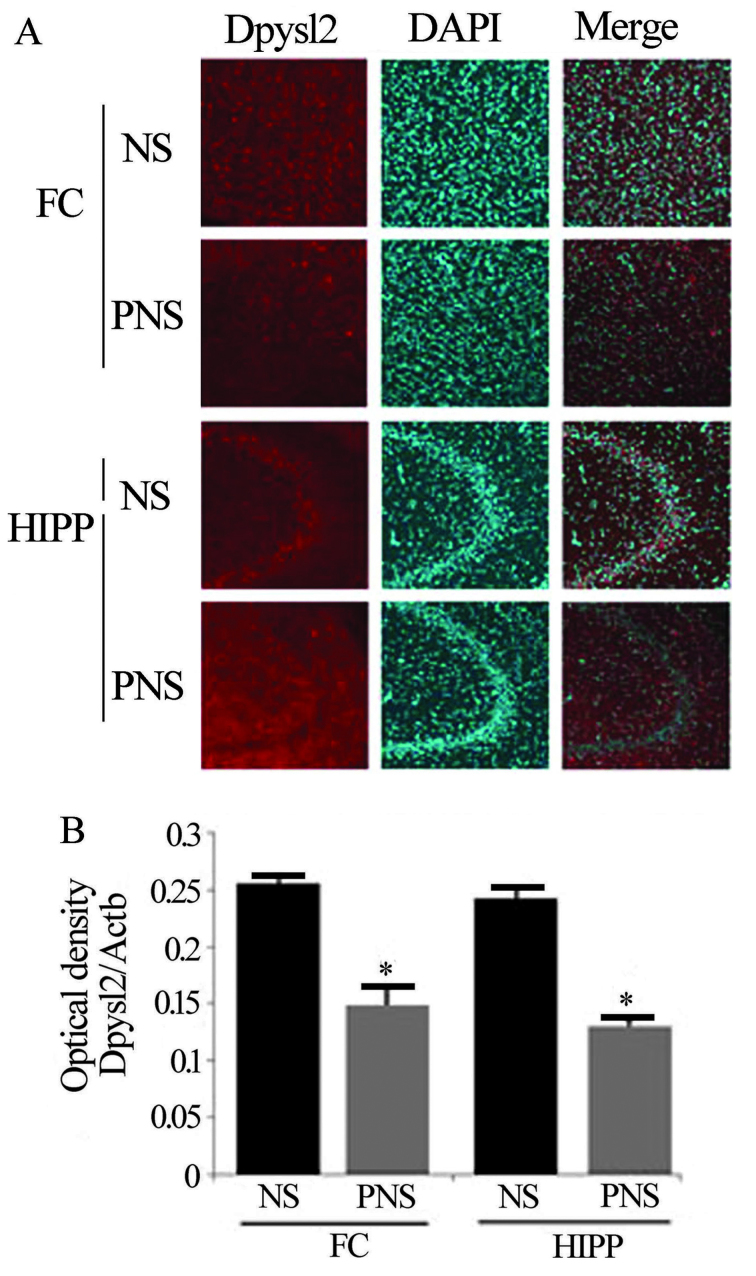
Immunohistochemical analysis of Dpysl2 expression in the brains of PNS-induced rats. (A) Confocal microscopic image showing immunofluorescent staining for Dpysl2 (anti-Dpysl2, red, Cy3) with DAPI in the prefrontal cortex and hippocampus. Fluorescent staining revealed decreased Dpysl2 in these regions. Scale bar, FC; 50 Hipp; 100 μm. (B) Optical densities of Dpysl2 signals in immunostained prefrontal cotex and hippocampus sections from (*P<0.05 compared with the NS group in the prefrontal cortex and hippocampus). Dpysl2, dihydropyrimidinase-like 2; FC, prefrontal cortex; Hipp, hippocampus; NS, non-prenatal stressed offspring; PNS, prenatal stressed offspring; SD, standard deviation.